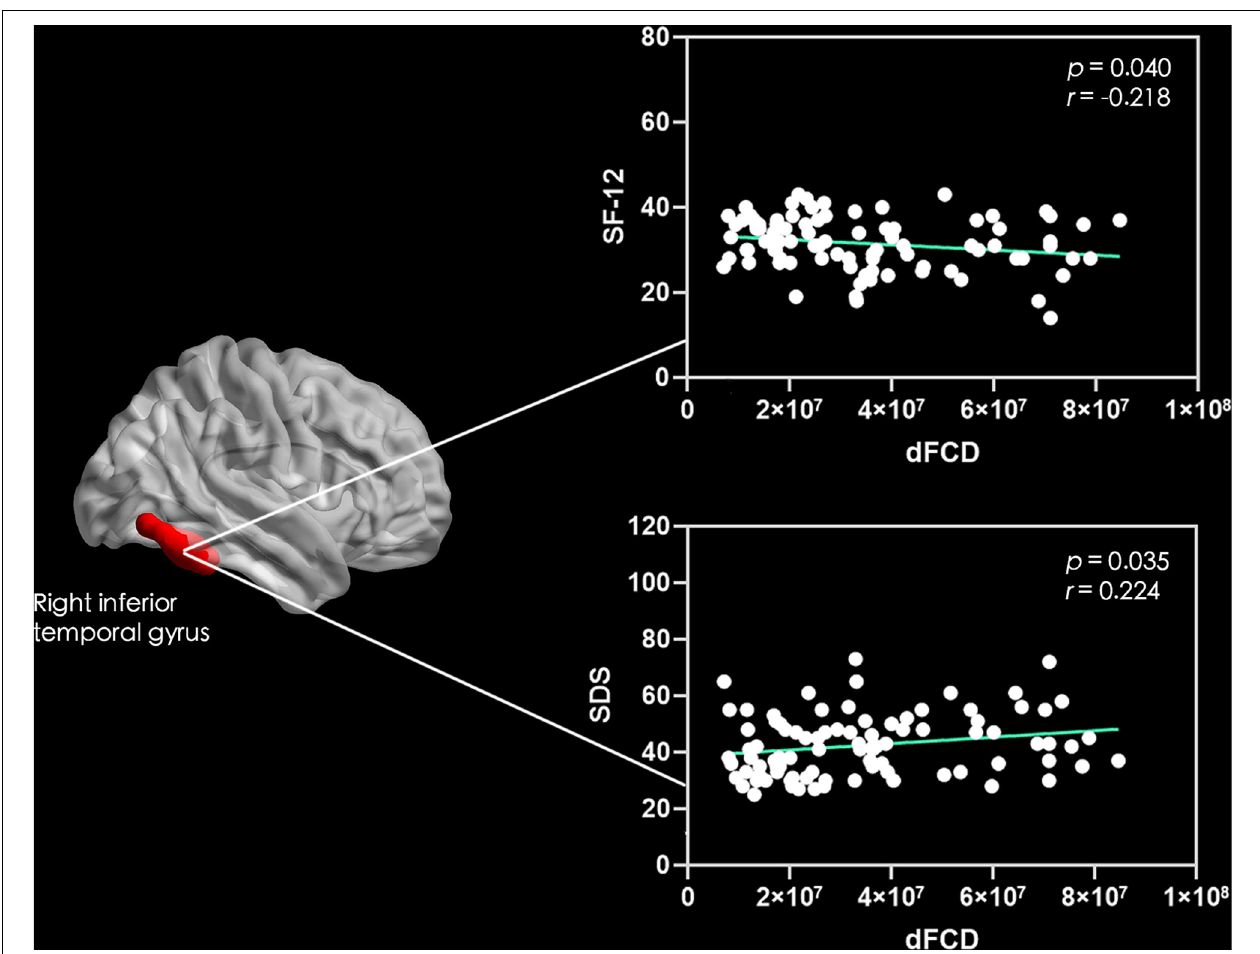
FIGURE 5 | Correlation between dynamic functional connectivity density (dFCD) variability in the right inferior temporal gyrus with SF-12 scores and self-rating depression scale (SDS) scores of the CNP Group. SF-12, short form 12 questionnaire; SDS, self-rating depression